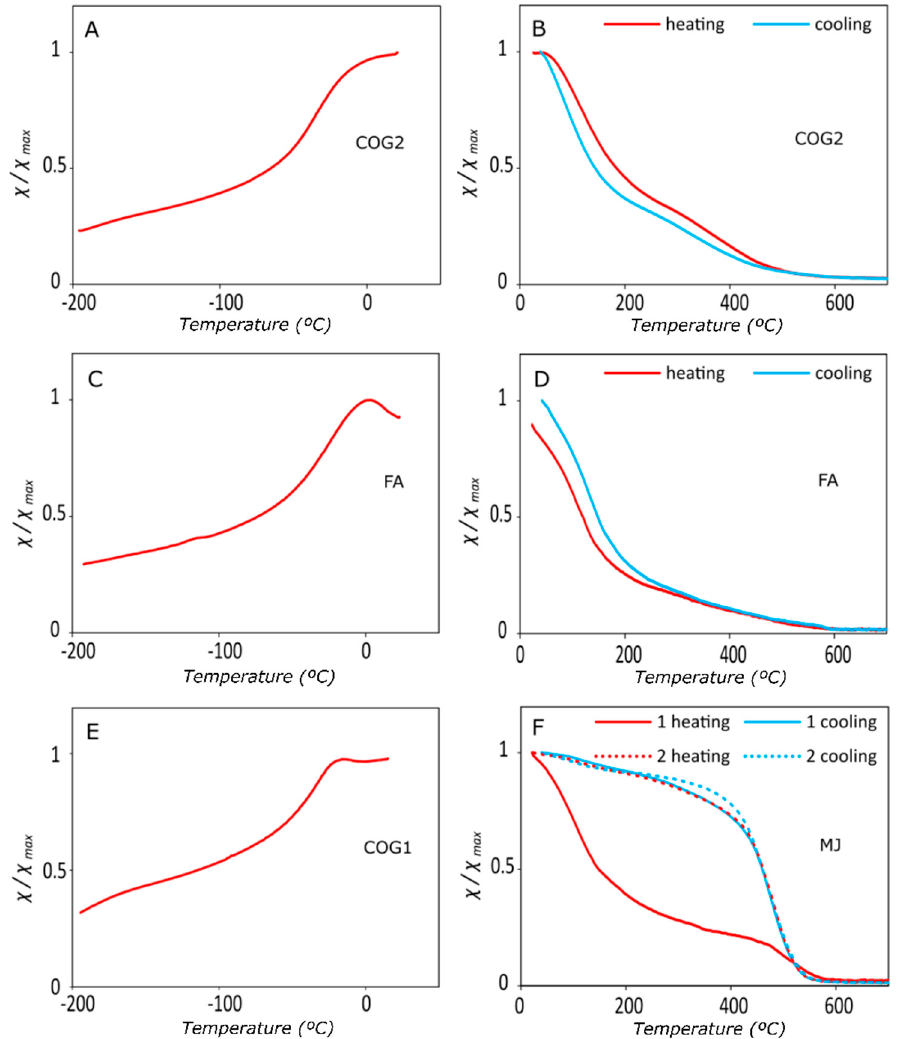
Figure 5. Susceptibility vs. temperature ( χ -T) thermomagnetic curves for lapilli (FA, MJ) and lava-flow (COG2, COG1) samples. ( A ) shows low-temperature curve for sample COG2. ( B ) shows high